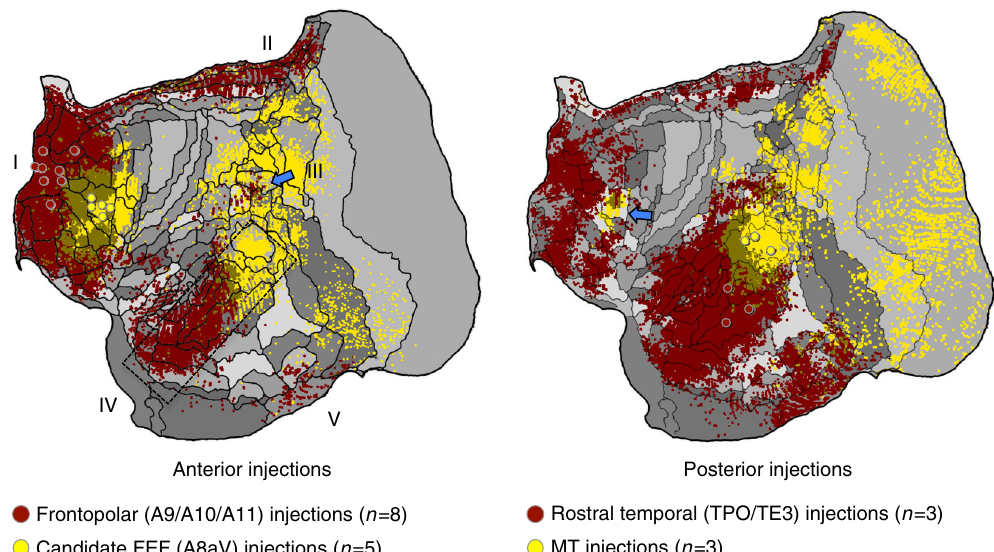
Fig. 6 The apex transmodal network is spatially distinct from a canonical distributed sensory-motor network. Images illustrate the contrast between injections within the apex transmodal network and the sensory-motor network linked to A8aV-MT. In each image, averages of multiple injections are contrasted. Displayed to the left are average projection maps for injections to frontopolar cortex (red) contrasted with A8aV injections (yellow). The distinct patterns of projections in posterior cortex are striking including that the apex transmodal network involves extensive regions of rostral temporal association cortex that are juxtaposed to caudal sensory-aligned regions (dashed rectangle) as well as a punctate region of parietal association cortex near PG/Opt that is surrounded by regions more aligned to the sensory-motor network (blue arrow). Displayed to the right are average projections for rostral temporal injections (TPO/TE3) contrasted to MT injections. This map reveals the anterior separation of the networks including the region near to A8aV (a putative homolog of FEF) that is preferentially distinct and caudal to the apex transmodal